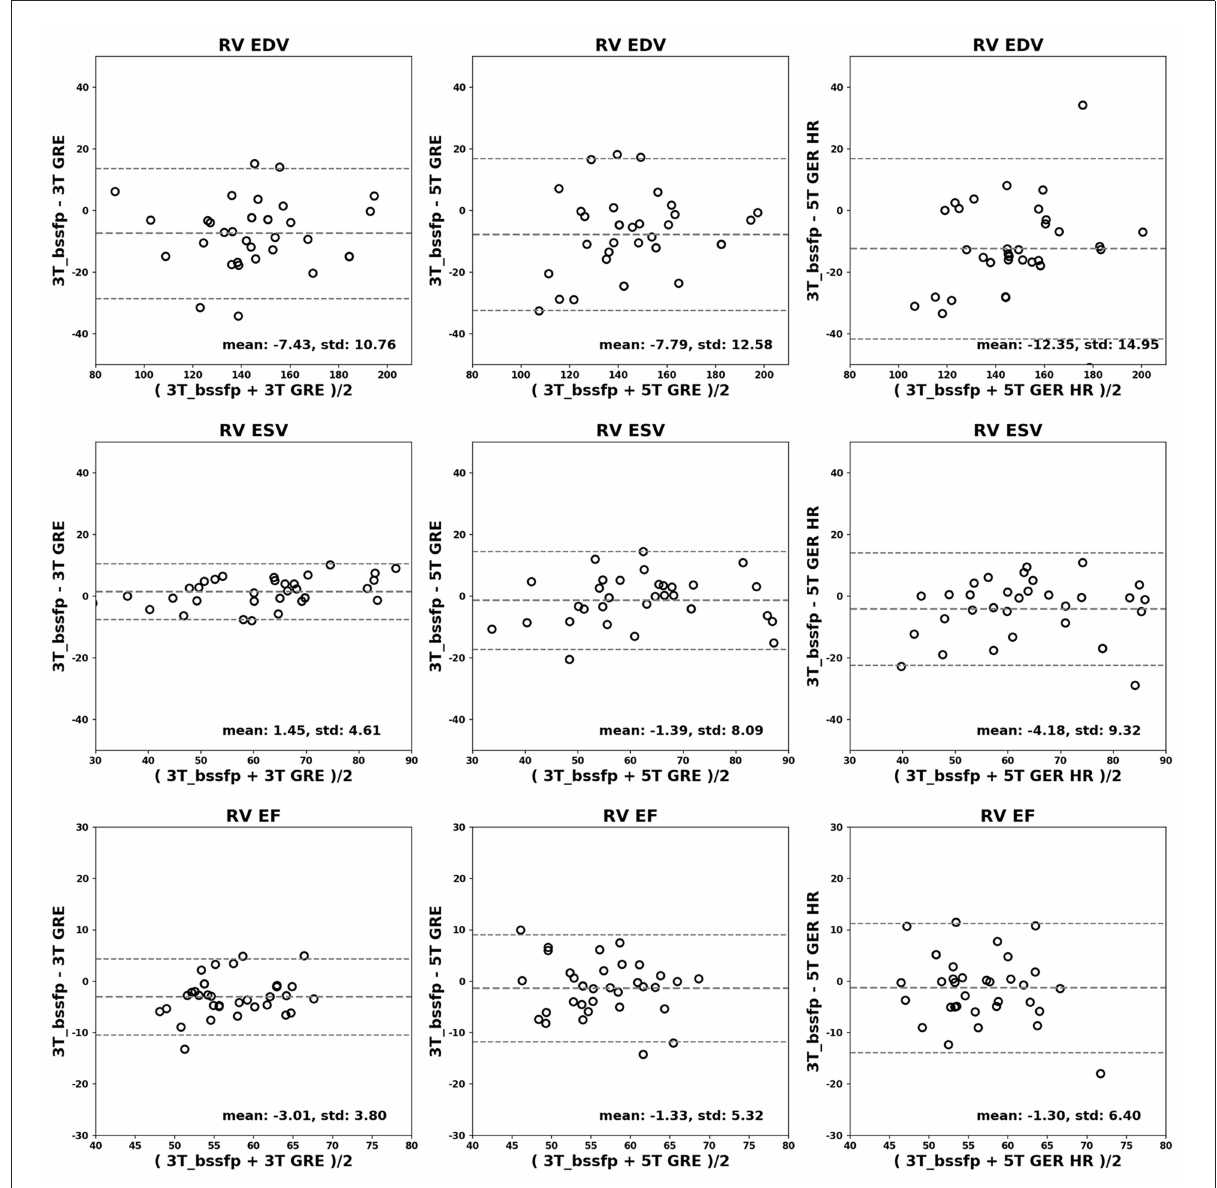
FIGURE5 Bland-Altman analyses for RV. RV EDV (ml), ESV (ml) and EF (%) are shown in rows. Comparisons of 3T GRE, 5T GRE, and 5T GRE HR to 3T bSSFP are shown in